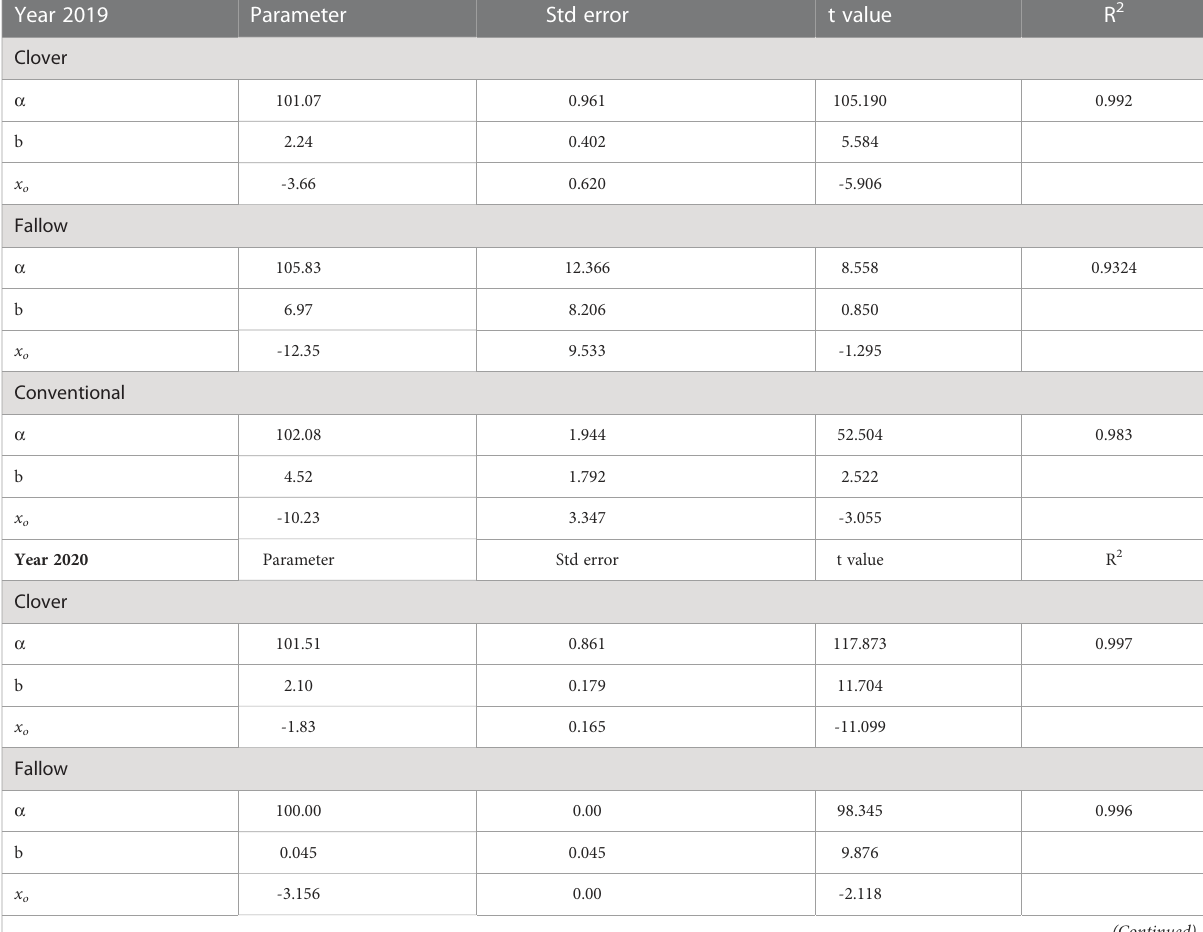
TABLE 3 Statistics of the three-parameter Gompertz regression model fi tted to relative corn yield to estimate the critical weed-free periods (CWFP) for each conservation tillage following a crimson clover cover crop (CT + CC), conservation tillage following winter fallow (CT + WF), and conventional tillage without a cover crop (CVT) treatment in 2019 and